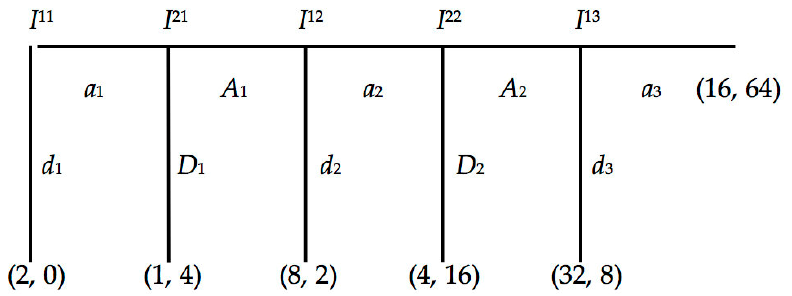
Figure 2. I ij is the j -th information set ( j ≥ 1) of agent i ( i = 1, 2). This Centipede Game has two pure strategies at each information set: Either ‘Down’ ending the game, or ‘Across’ allowing the other agent to choose an action. The agents’ payoffs are represented at the tree’s endpoints, the left member being the first agent’s payoff, the right member being the second agent’s payoff. The backward induction profile is ( d 1 d 2 d 3 , D 1 D 2 ).